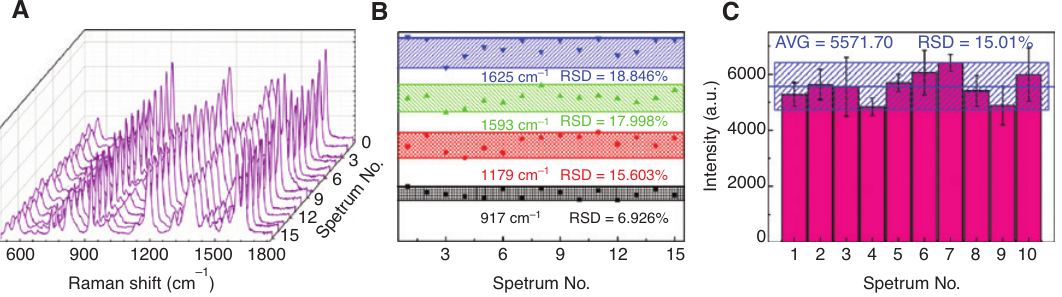
Figure 6: Homogeneity and reproducibility detection on the AgNPs/PVA@Ag nanofibers. (A) The Raman spectra of CV (10 −6 m) randomly collected on the AgNPs/PVA@Ag nanofibers substrate. (B) The intensity distributions of the 917, 1179, 1593, and 1625 cm −1 peaks for CV from (A). (C) The intensity distribution of the 917 cm −1 peaks of CV (10 −6 m) respectively collected from 10 different batches AgNPs/PVA@Ag nanofibers substrate.